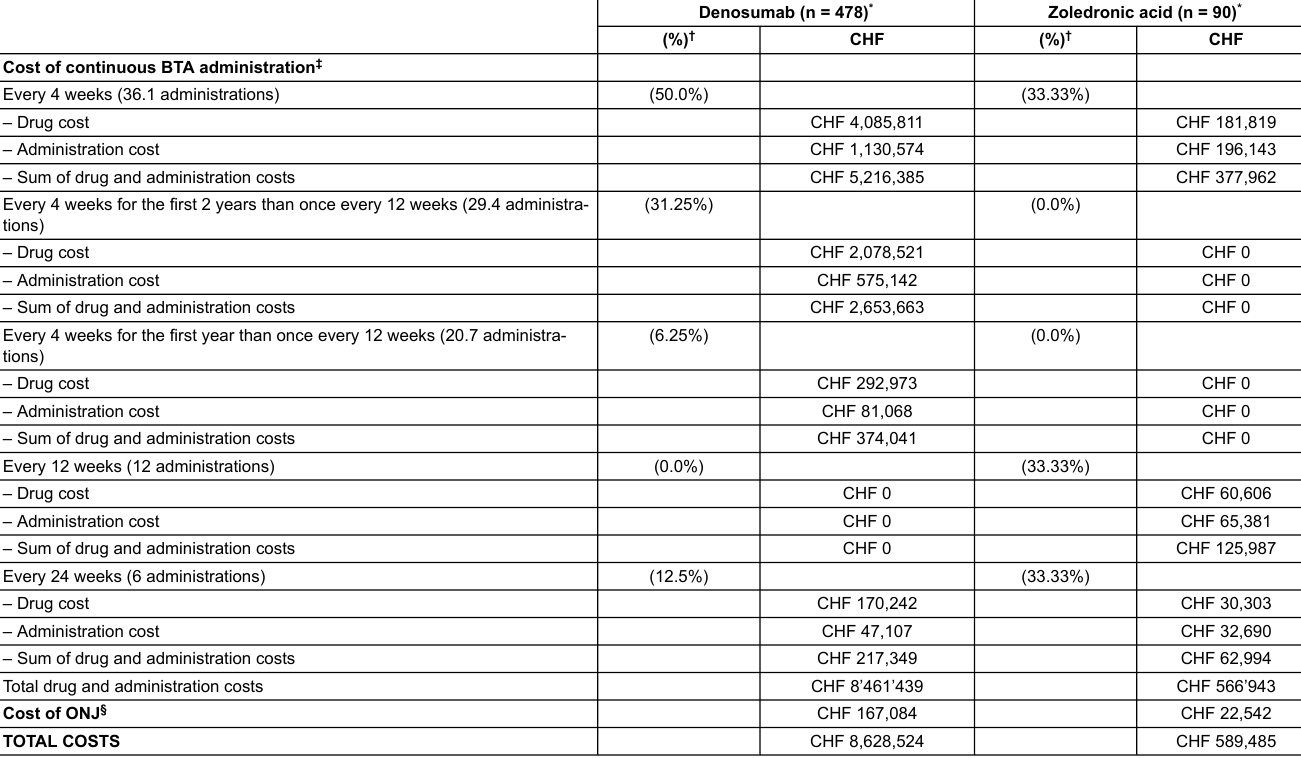
Table 4: Estimated total cost of BTA use for a cohort of 568 mCSPC